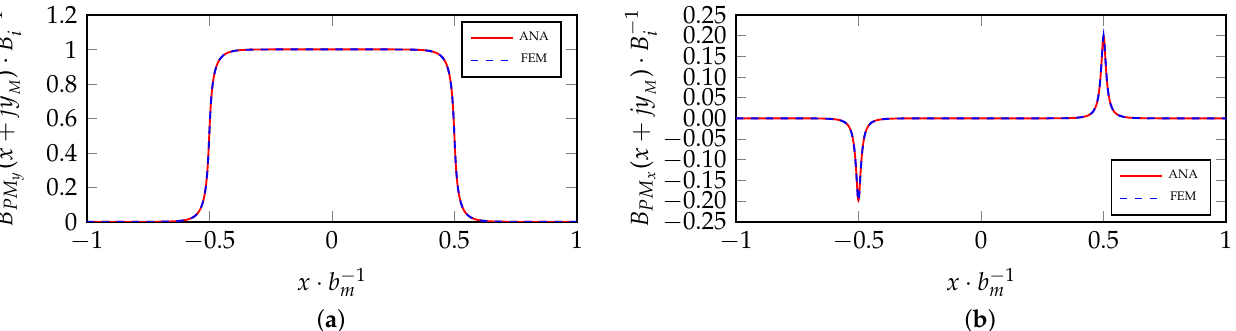
Figure 3. Analytical and FEM flux density distributions, on the middle mechanical air-gap line, caused by an SPM between two smooth iron surfaces ( ( b ) tangential component.